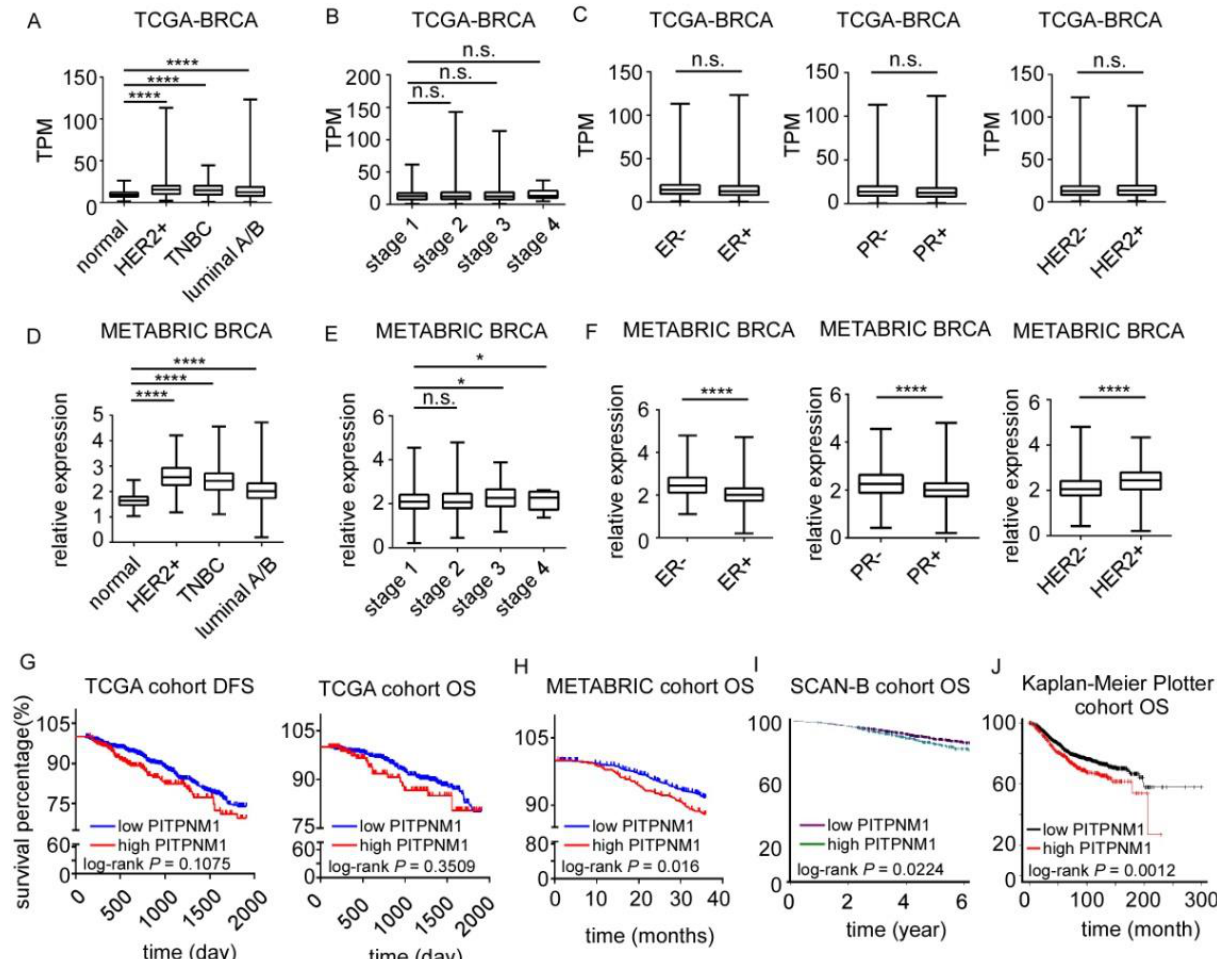
Figure 1. Prognostic value of PITPNM1 in breast cancer. ( A ) The expression of PITPNM1 in different molecular subtypes of breast cancer of TCGA cohort. Triple-negative cancer, TNBC, n = 160; human epidermal growth factor receptor 2 over-expression, HER2+, n = 33; luminal A/B, n = 711; normal breast tissue n = 113. **** p < 0.0001. ( B ) The expression of PITPNM1 in different stages of breast cancer of TCGA cohort. ( C ) The association of PITPNM1 with estrogen receptor (ER) status, progesterone receptor (PR) status, and HER2 status in TCGA cohort. n.s., not significant, p > 0.05. ( D ) The expression of PITPNM1 in different molecular subtypes of breast cancer of METABRIC cohort. TNBC, n = 299; HER2+, n = 127; luminal A/B, n = 1464; normal breast tissue n = 147. **** p < 0.0001. ( E ) The expression of PITPNM1 in different stages of breast cancer of METABRIC cohort. n.s., not significant, p > 0.05; * p < 0.05. ( F ) The association of PITPNM1 with estrogen receptor (ER) status, progesterone receptor (PR) status, and HER2 status in METABRIC cohort. **** p < 0.0001. ( G ) The prognosis of PITPNM1 in TCGA breast cancer cohort. Disease-free survival time, DFS; overall survival, OS. ( H ) The prognosis of PITPNM1 in METABRIC cohort. ( I ) The prognosis of PITPNM1 in SCAN-B cohort. ( J ) The prognosis of PITPNM1 in Kaplan–Meier cohort.